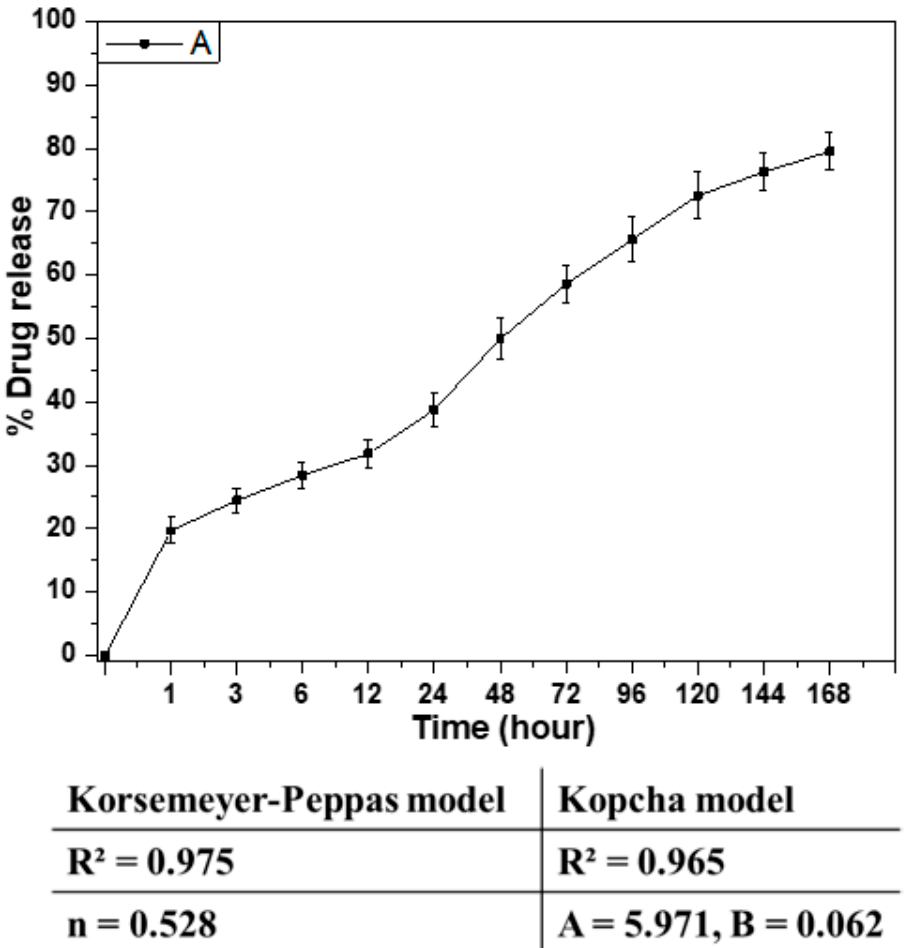
Figure 2. Cumulative in vitro drug release of (A) PCL-PGS-HA-SIM composite nanofiber in PBS. The table shows the in vitro release kinetics of SIM in PBS.